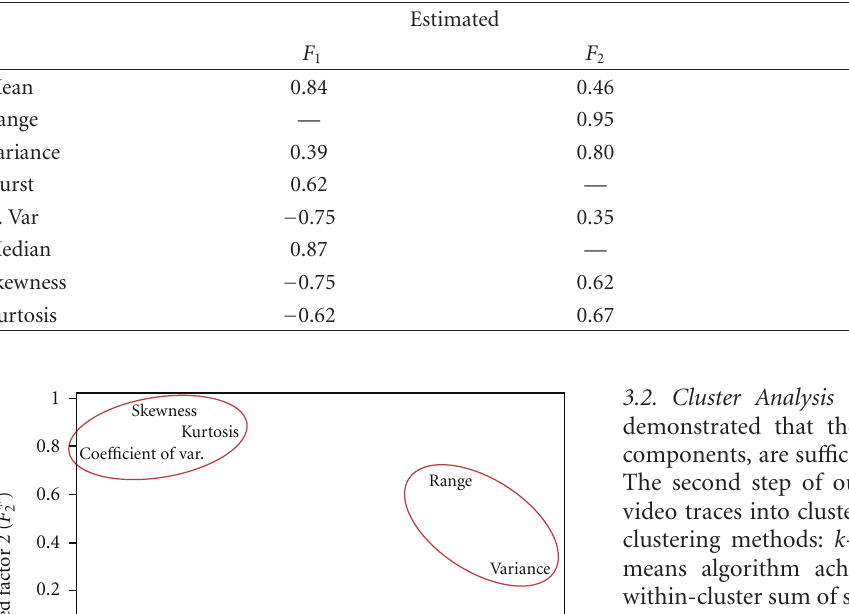
Table 4: Estimated and rotated factors loadings.